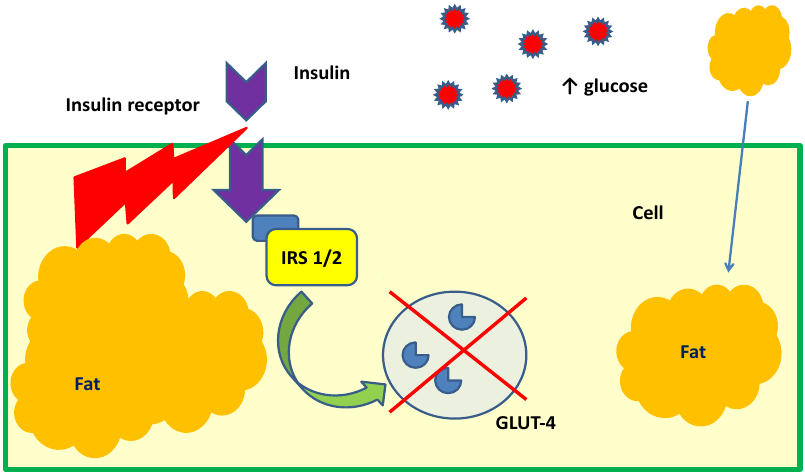
Figure 3. Mechanism of insulin resistance in the cell [27].